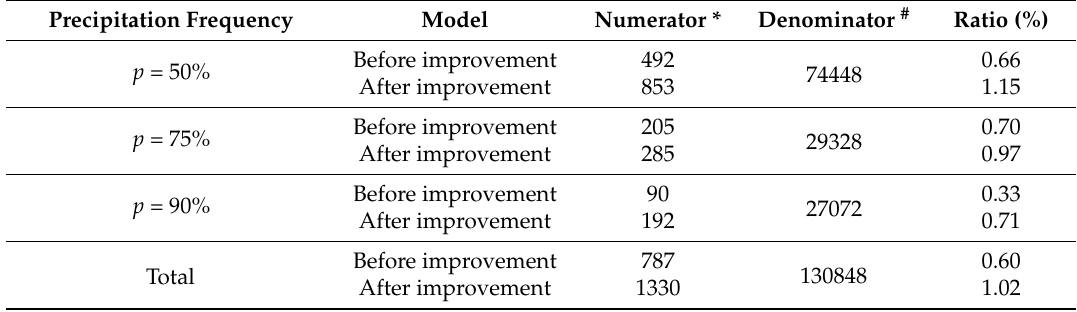
0.66 74448 0.70 29328 0.33 27072 0.60 130848